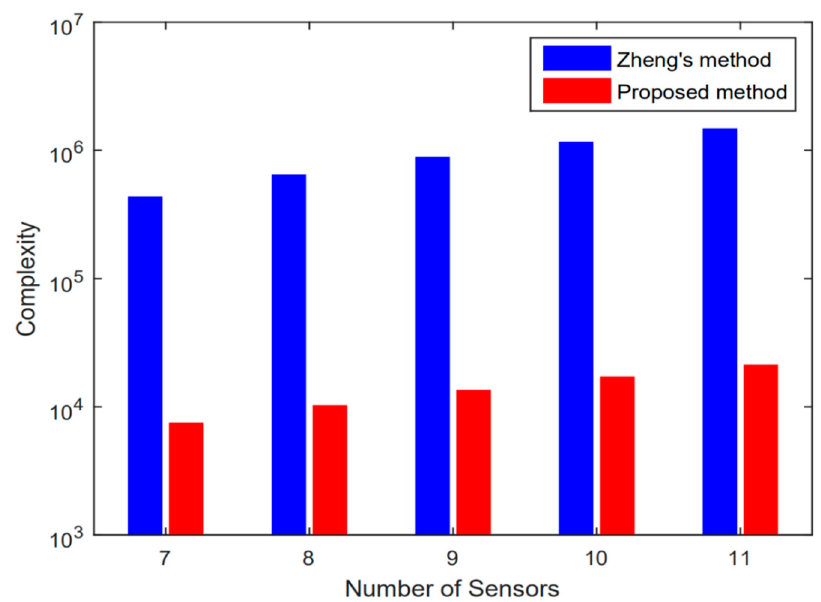
Figure 5. Complexity comparison.